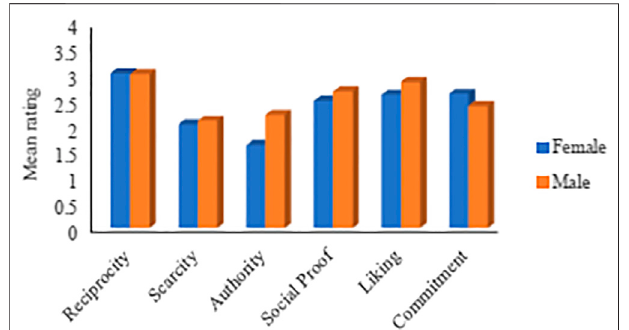
FIGURE 2 | Mean rating based on gender (Female: 35%, Male: